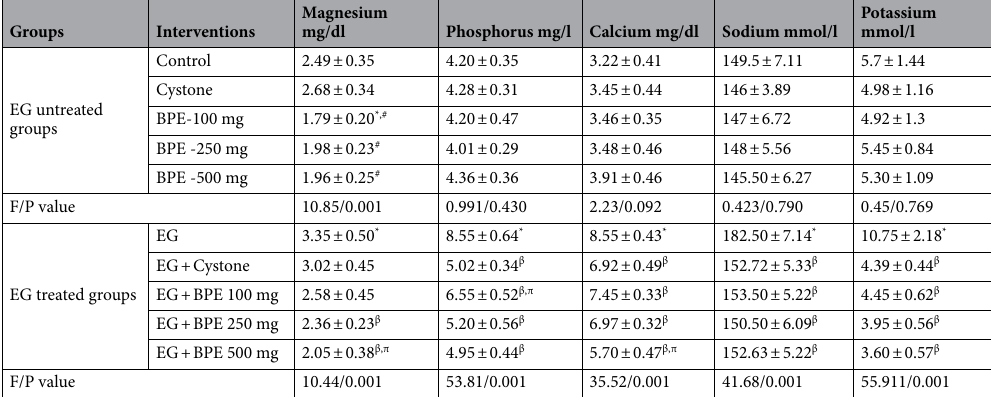
Table 2. Effect of the interventions on blood level of electrolytes on day 30. * P < 0.05 compared to EG untreated-control group. # P < 0.05 compared to EG untreated-cystone group. β P < 0.05 compared to EG treated group. π P < 0.05 compared to EG treated-EG + cystone group.